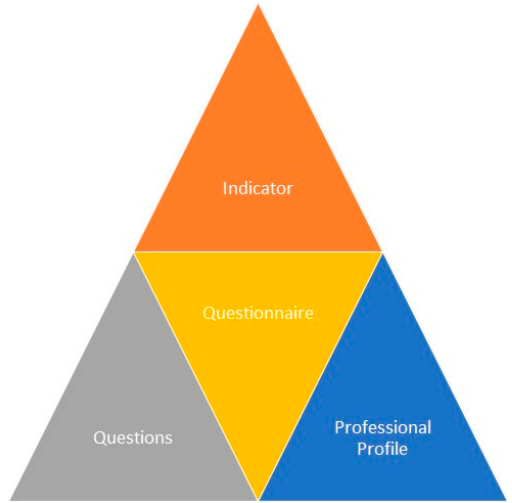
Figure 3. Methodology for calculating the values of the indicators.